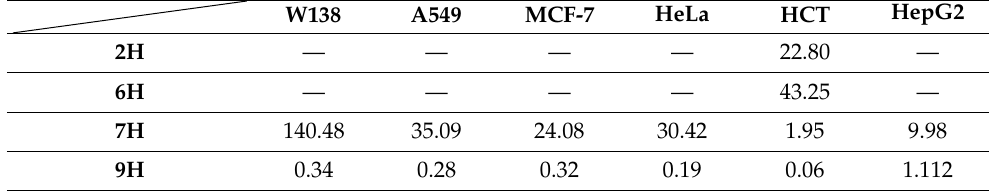
W138: normal human lung cell line, A549: lung cancer cell line, MCF-7: breast cancer cell line, HeLa: cervical cancer, HCT: colorectal cancer, HepG2: liver cancer cell